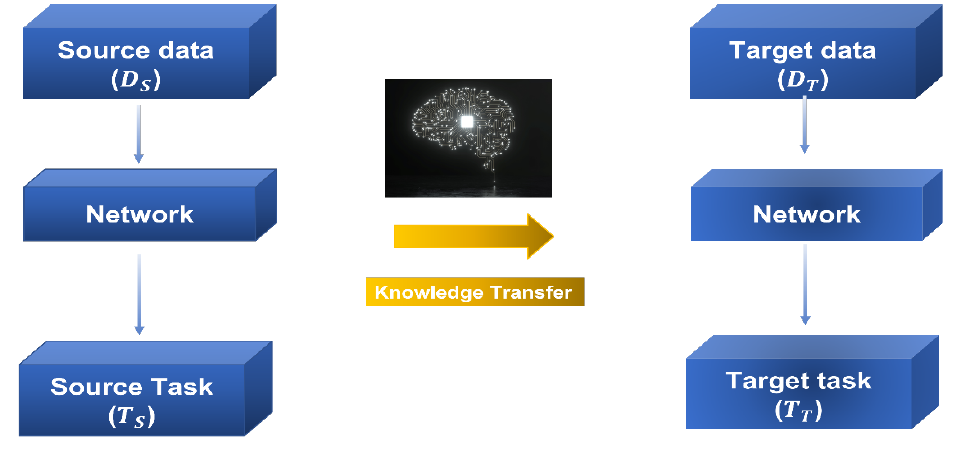
Figure 3. Transfer learning